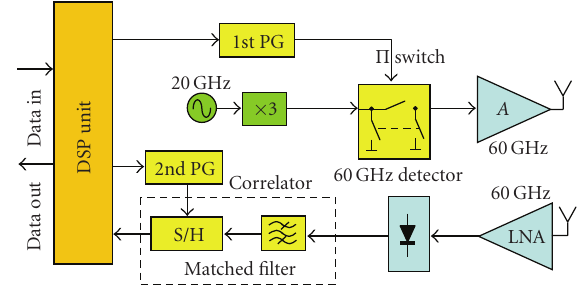
Figure 7: The simplified block diagram of an impulse-radio